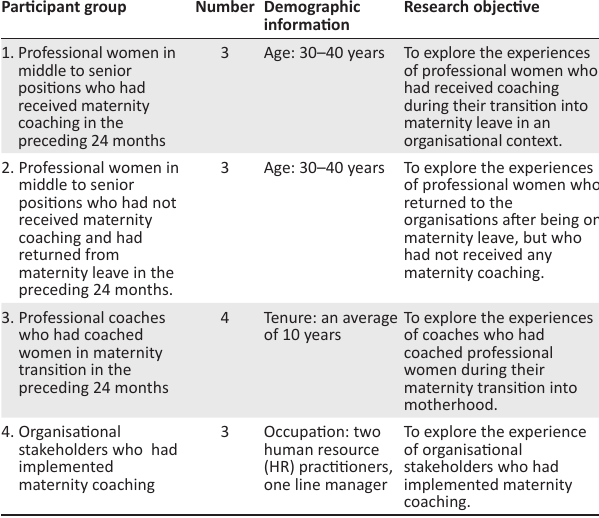
TABLE 1: Rational and inclusion criteria for the four participant groups from different corporate organisations. Participant group